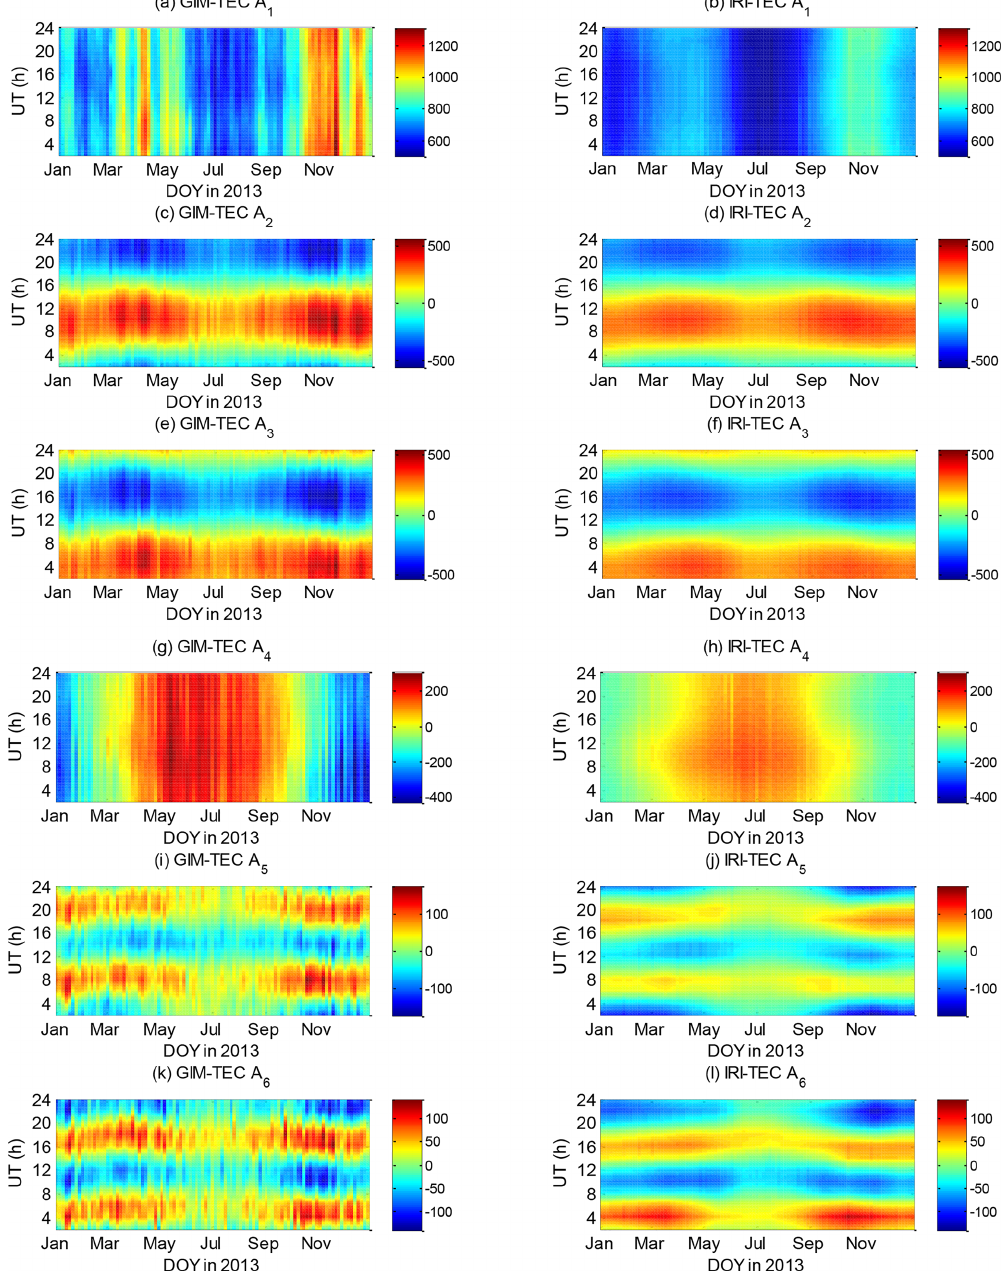
Figure 9. Associated coefficients A 1 – A 6 of the EOF base functions extracted in accordance with Eq.